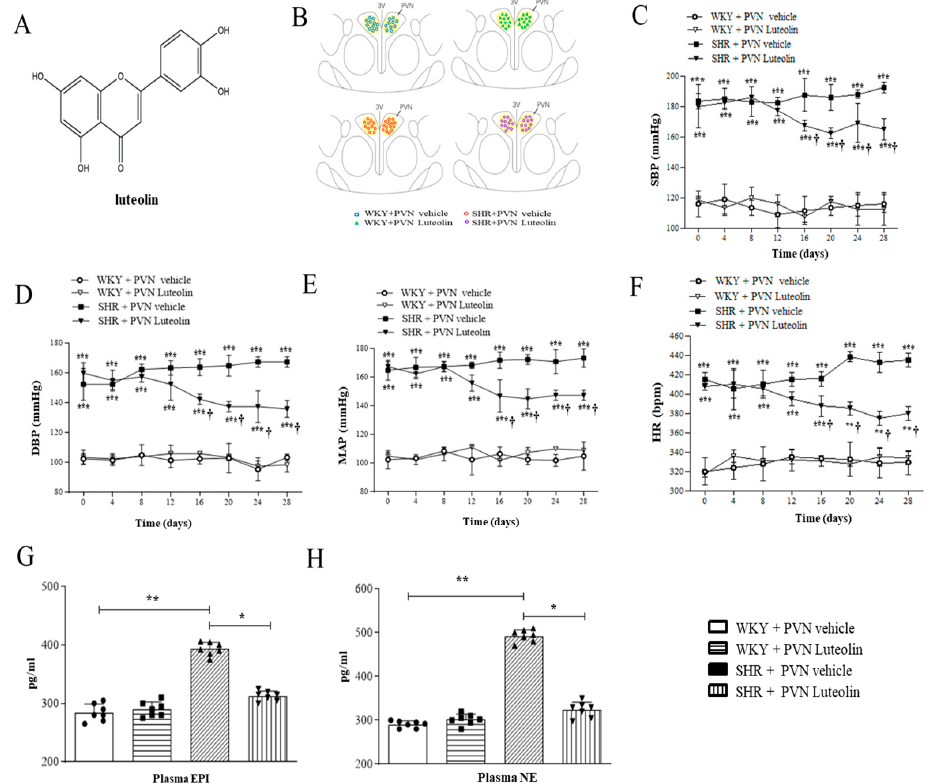
Figure 1. Effects of PVN luteolin on blood pressure, the plasma levels of NE, and EPI. ( A ) Structural formula of luteolin. ( B ) Schematic representation of microinjection sites. ( C ) The systolic blood pressure (SBP) in different groups. ( D ) The diastolic blood pressure (DBP) in different groups. ( E ) The mean arterial pressure (MAP) in different groups. ( F ) Heart rate (HR) in different groups. ( G ) ELISA detection of the plasma level of EPI in different groups. ( H ) ELISA detection of plasma level NE in different groups. Values are mean ± SEM. * p < 0.05, ** p < 0.01 and *** p < 0.001 versus WKY groups (WKY + PVN vehicle or WKY + PVN luteolin); † p < 0.05 SHR + PVN vehicle versus SHR + PVN luteolin.